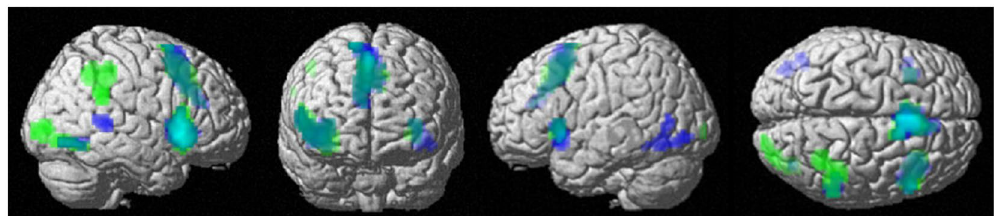
Figure 4. Overall connectivity with bilateral putamen irrespective of cycle phase and Stop signal reaction time (SSRT) for inhibited Stop trials: Overall connectivity network with left putamen [ − 18, 8, − 5] in green, and with right putamen [21, 11, − 5] in dark blue. Overlap areas in light blue. Uncorrected p < 0.001, pFWE < 0.05 at cluster level, and extent threshold of k = 40